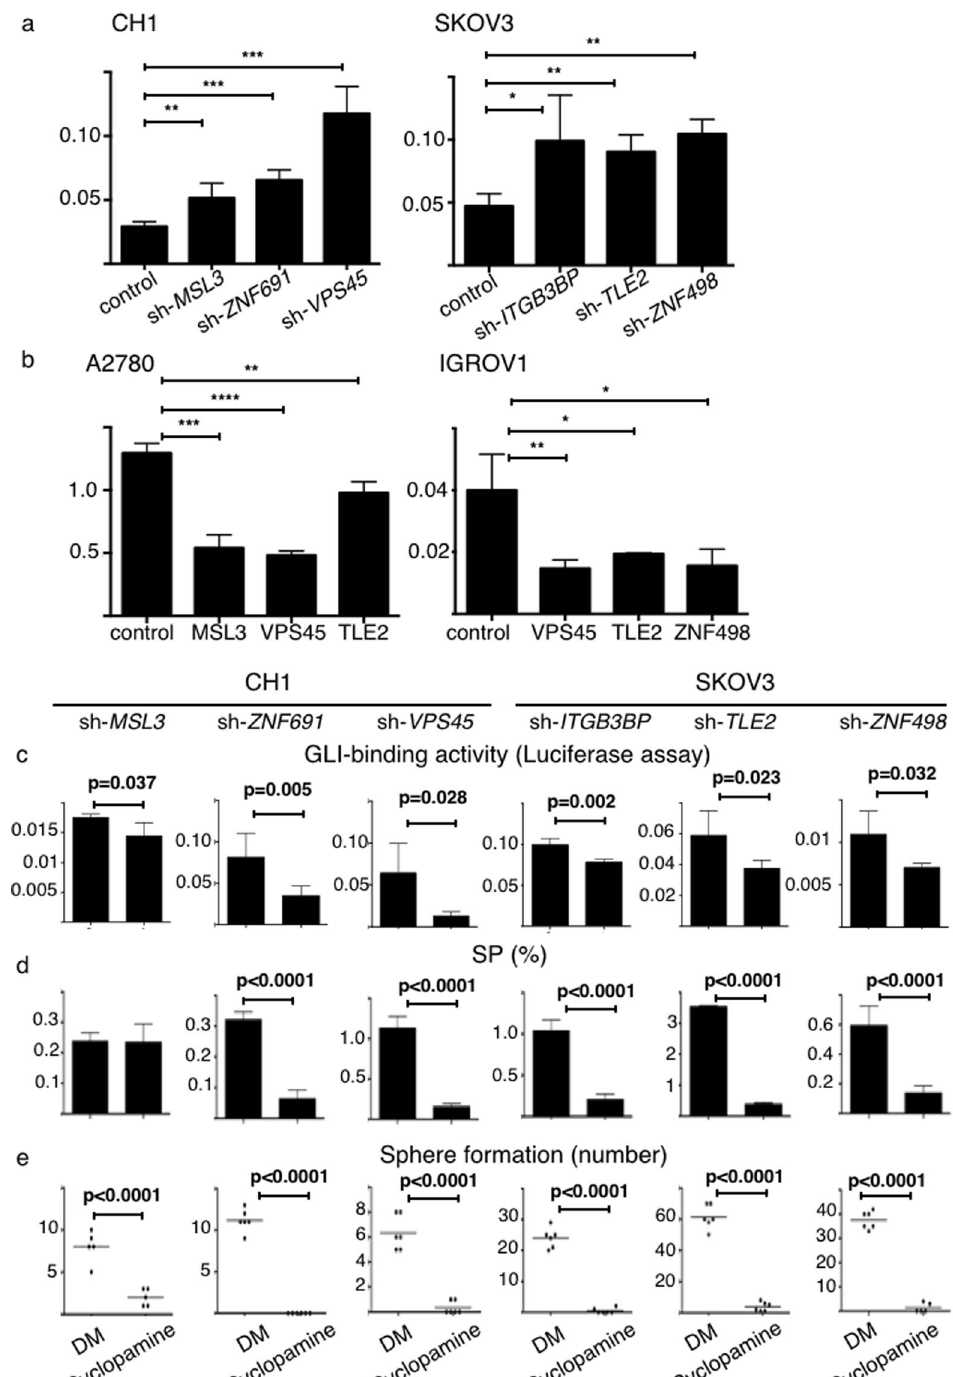
Figure 6. Six genes regulate CSC-like functions via the Hedgehog pathway. DM; DMSO. * p < 0.05, ** p < 0.01, *** p < 0.001, **** p < 0.0001. ( a , b ) GLI-binding activity measured using a luciferase reporter assay. Relative luciferase activities (y-axis) are shown (n = 4). ( a ) Suppression of the six genes significantly increases GLI-binding activity compared to control cells. ( b ) Overexpression of sMDL3, VPS45, TLE2 and ZNF498 significantly decrease GLI- binding activity (y-axis) compared to control cells. ( c ) Cyclopamine inhibits GLI-binding activity, measured using a luciferase reporter assay. ( d ) Cyclopamine decreases the SP, with the exception of SP cells derived from suppression of MSL3 . ( e ) Cyclopamine decreases sphere forming capacity of SP cells derived from suppression of six